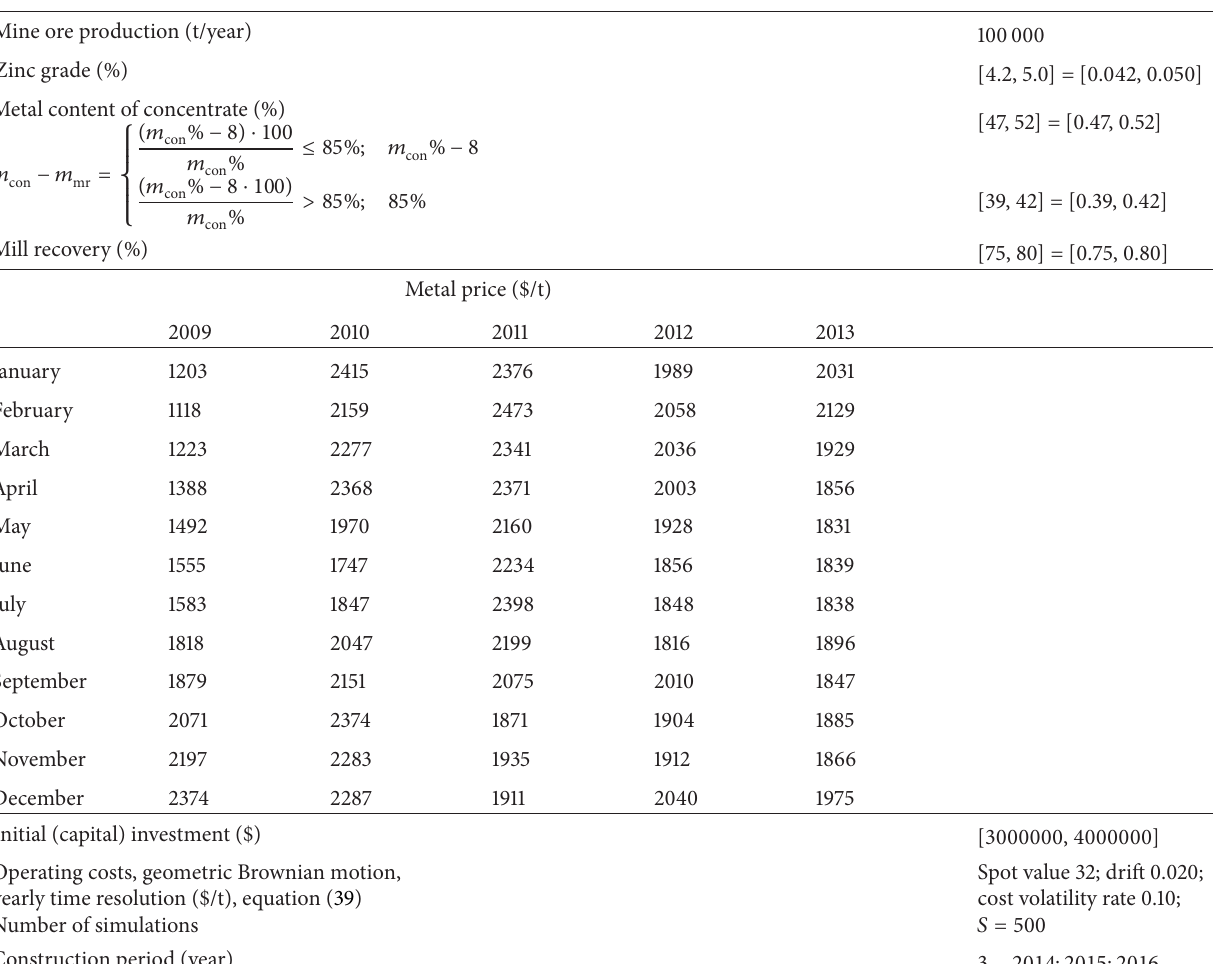
Table 1: Input parameters.